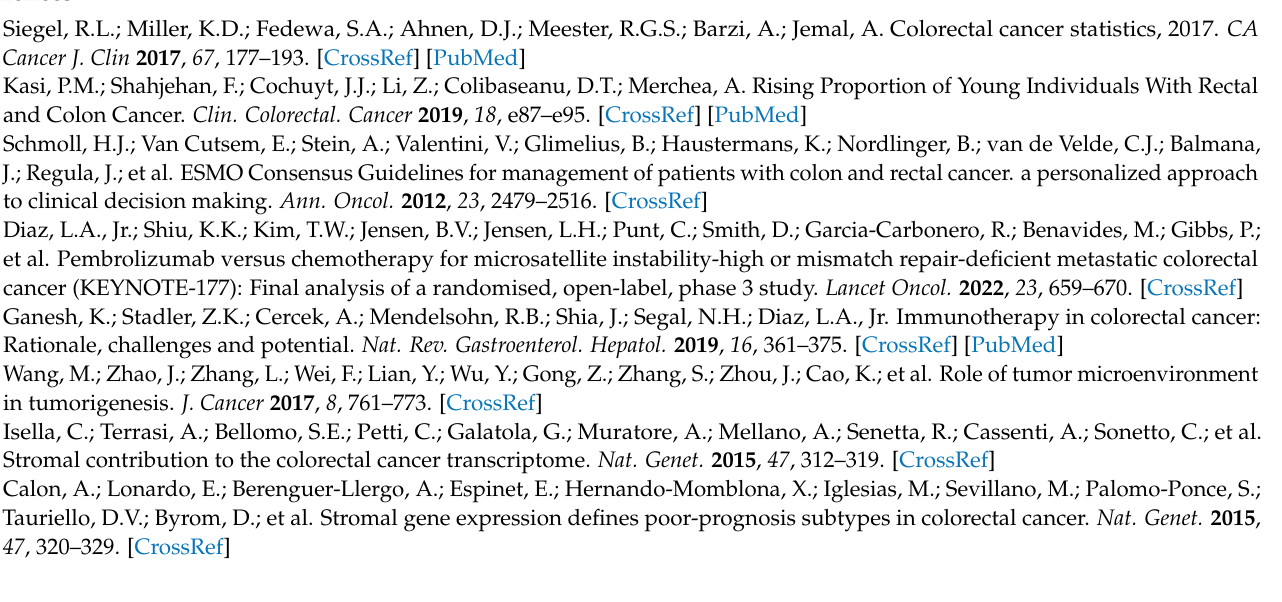
algorithm.; Figure S6: Correlation of COMP with somatic; Figure S7: The correlations between COMP expression and putative immunotherapy response in external